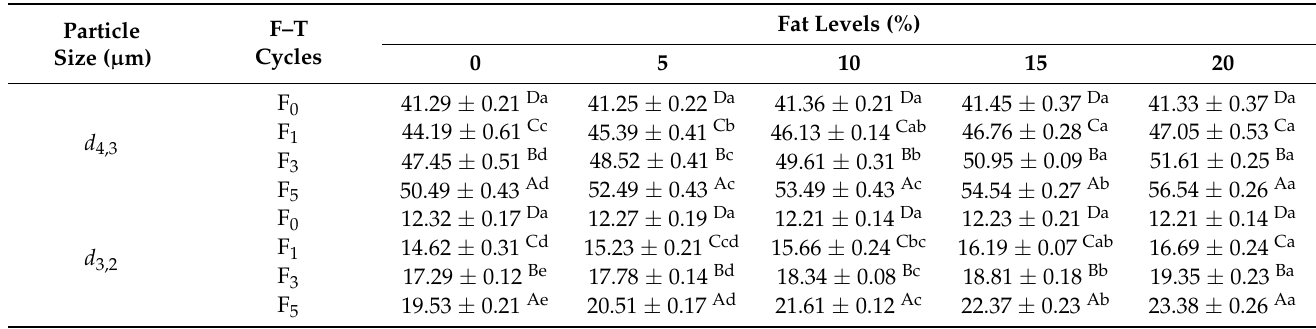
Table 1. Influence of F–T cycles on particle size ( d 4,3 and d 3,2 ) of myofibrillar protein from quick-frozen patties with different fat